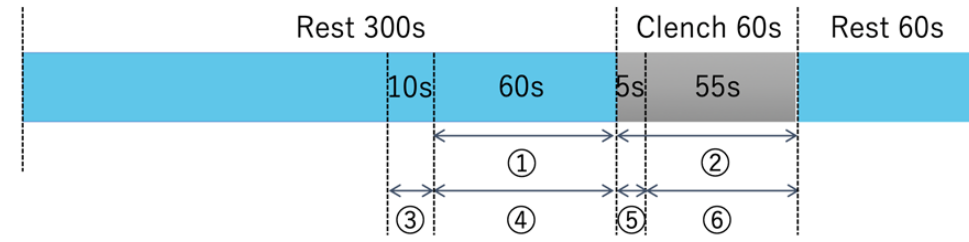
Figure 1. Time course of measurement. Rest 300 s: 300 s at rest, with the subject in sitting position, immediately before “Clench.” Clench: At 40% MVC, while in sitting position, the subject performs a 60 s tooth clenching task at 40% MVC. Rest 60s: 60 s at rest, with the subject in sitting position, immediately following “Clench.” Brain activity was evaluated using hemoglobin data, as follows: ( 1 ) Rest